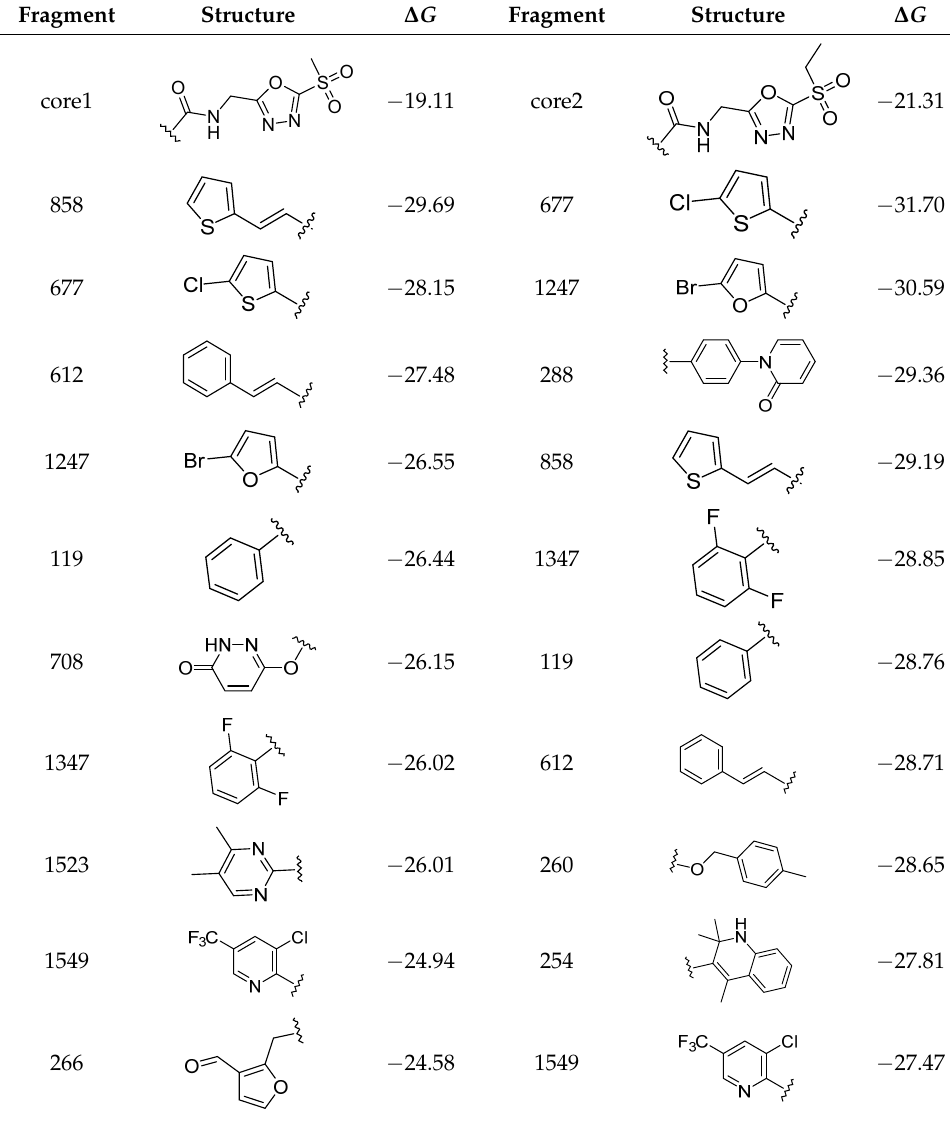
Table 3. The fragment structure generated from core 1 and 2 via ACFIS webserver.